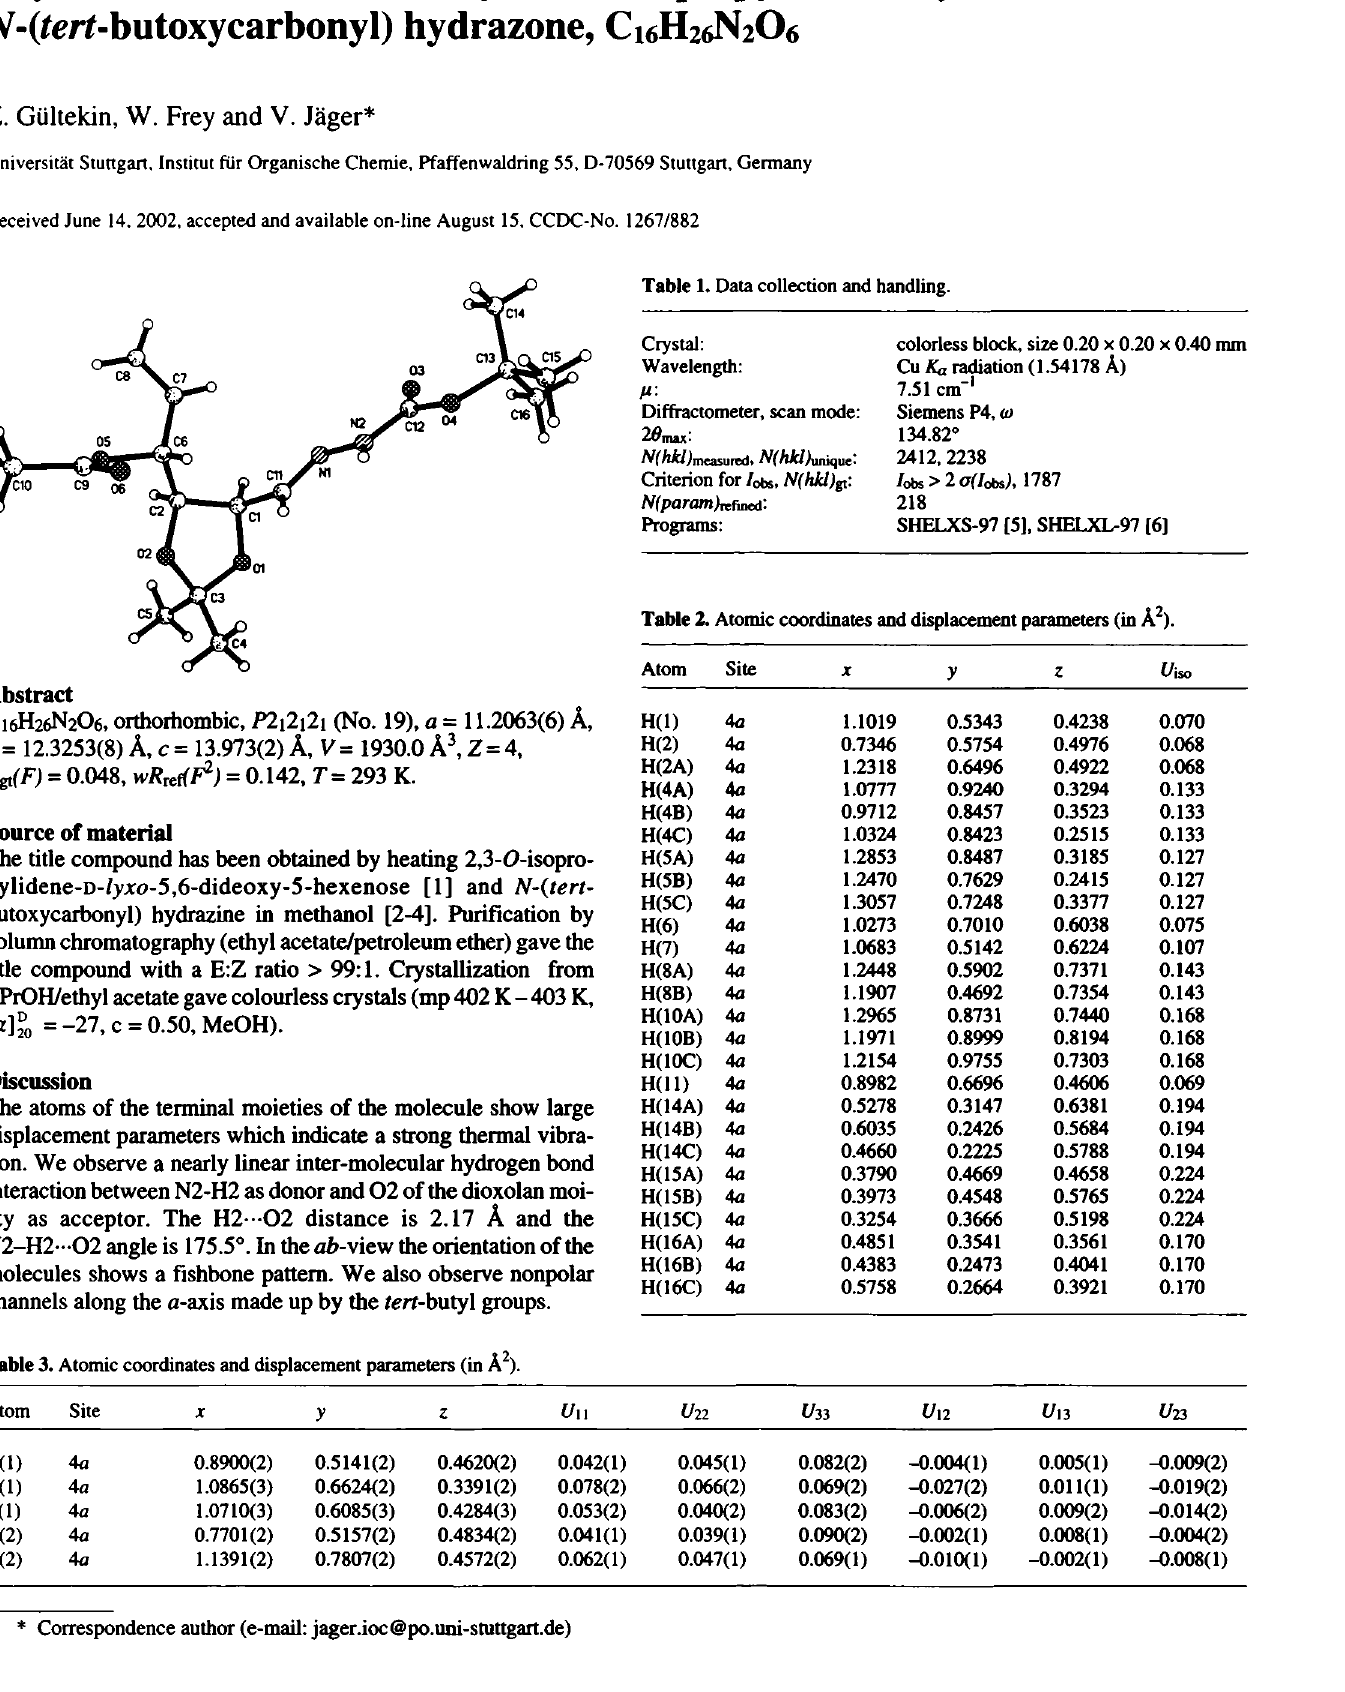
Table 1. Data collection and handling.